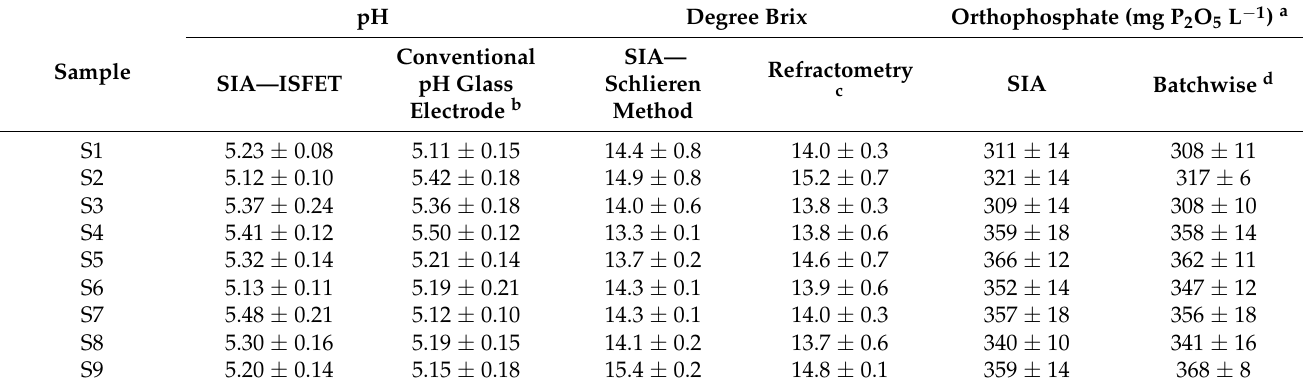
Table 4. Analysis of sugarcane juice using the developed SIA (Figure 1a) system as compared with comparative methods. Quantification was carried out in triplicate